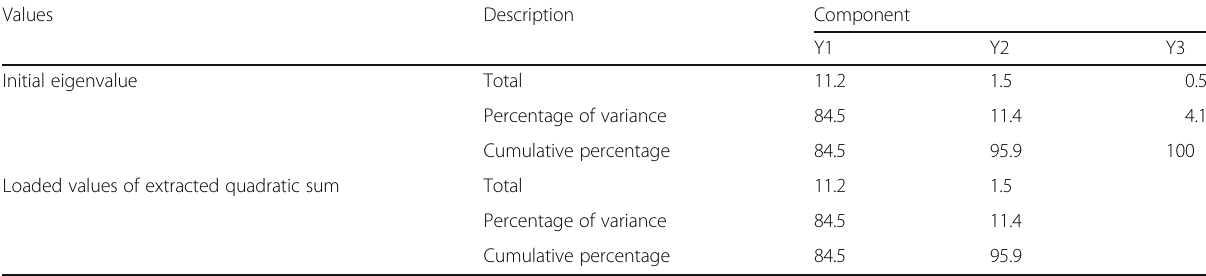
Table 4 Total contribution ratio of variance